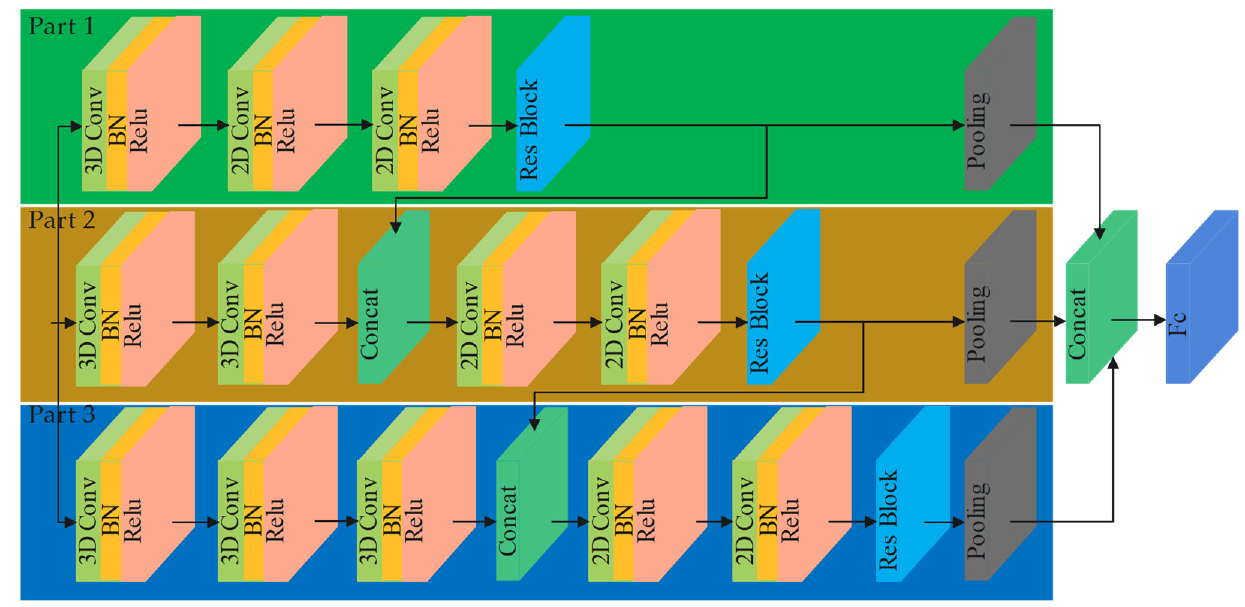
Figure 2. Hybrid Pyramid Feature Fusion Network Architecture.